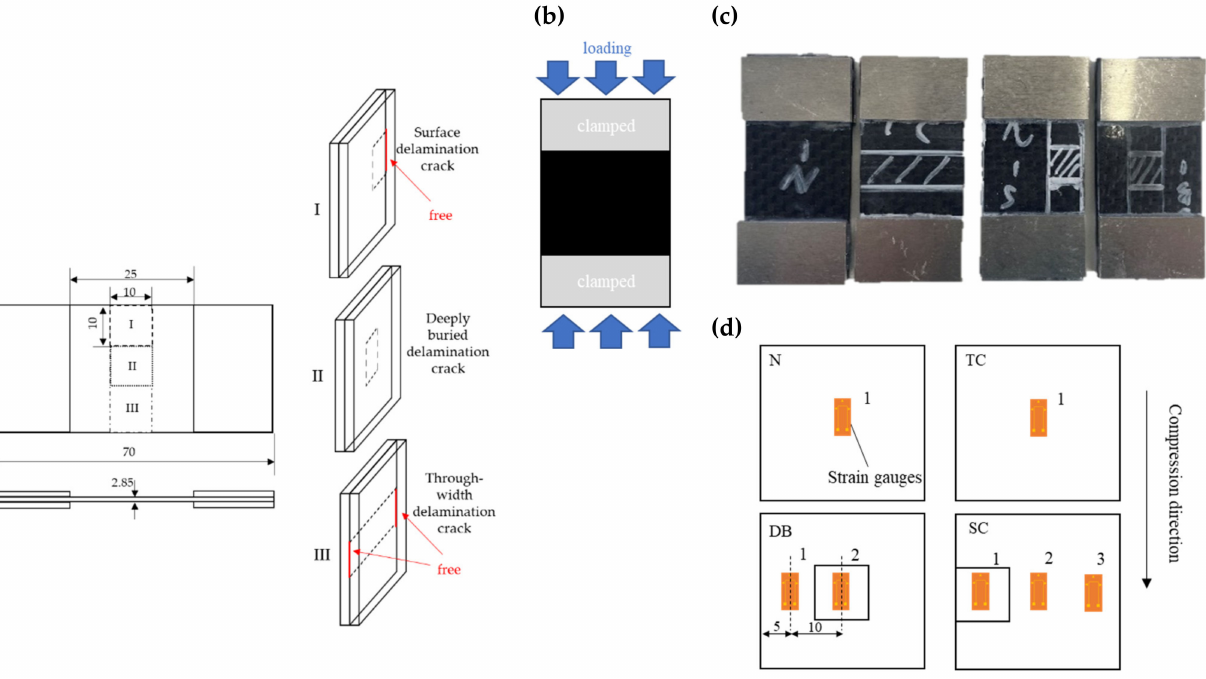
Figure 1. Schematic diagrams of ( a ) specimens with different types of embedded delamination; ( b ) loading method; ( c ) physical drawing of specimens; ( d ) location of strain